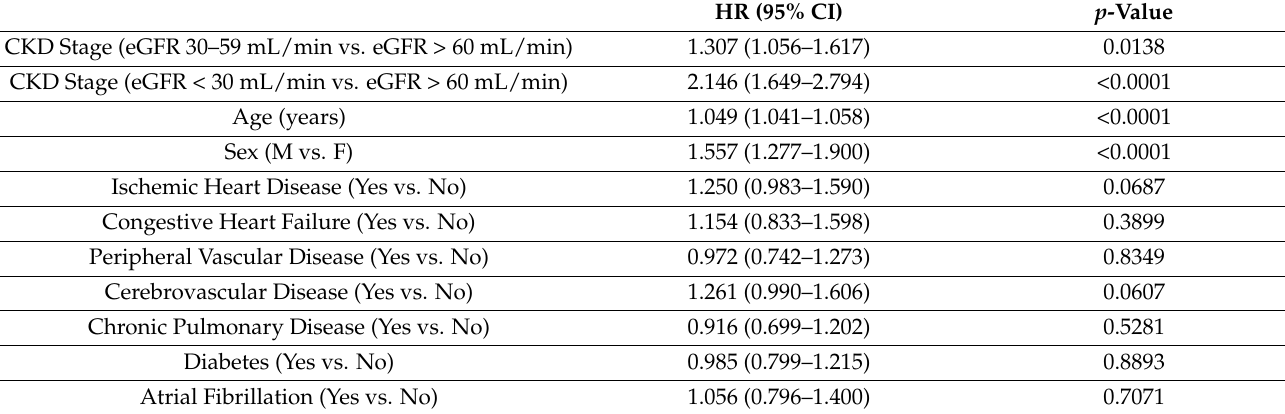
Table A1. Cox proportional hazards model on the impact of clinical factors on in-hospital mortality. Confounding variables with a significance level of <0.1 were retained in the final model. n = 2811, death = 504. HR (95% CI) p